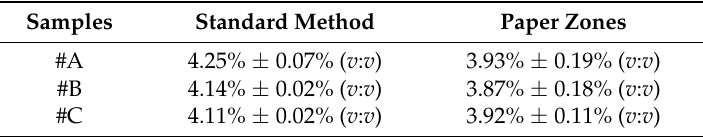
Table 1. Comparison of the acetic acid levels achieved in vinegar samples through classical acid–base titration and the proposed method using wax printed paper-based microzones ( n =